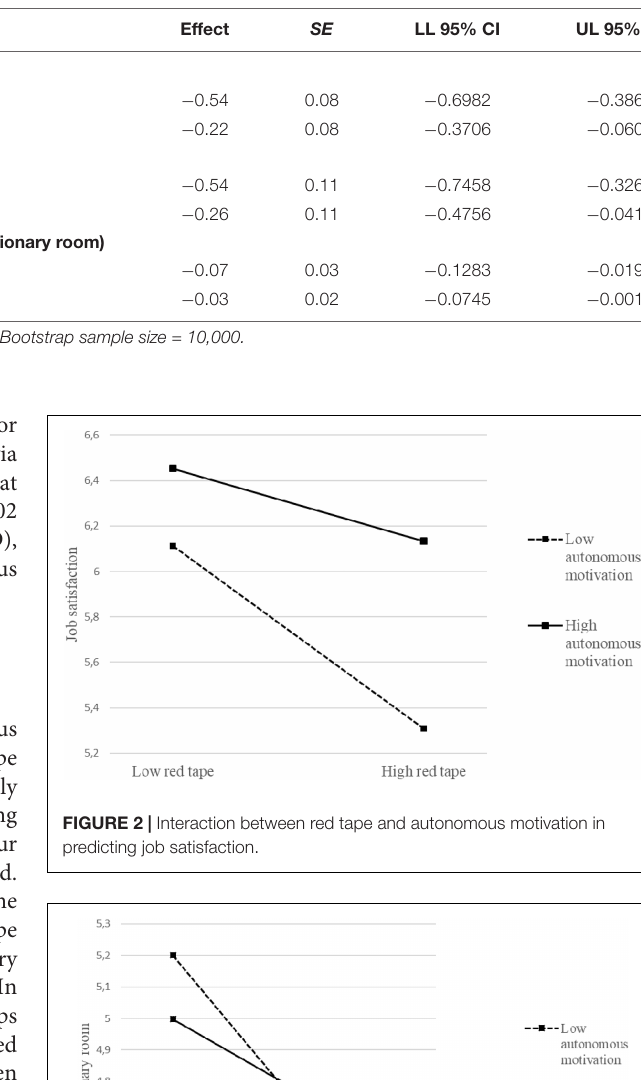
TABLE 4 | Results of the conditional direct and indirect effects for different levels of autonomous motivation.